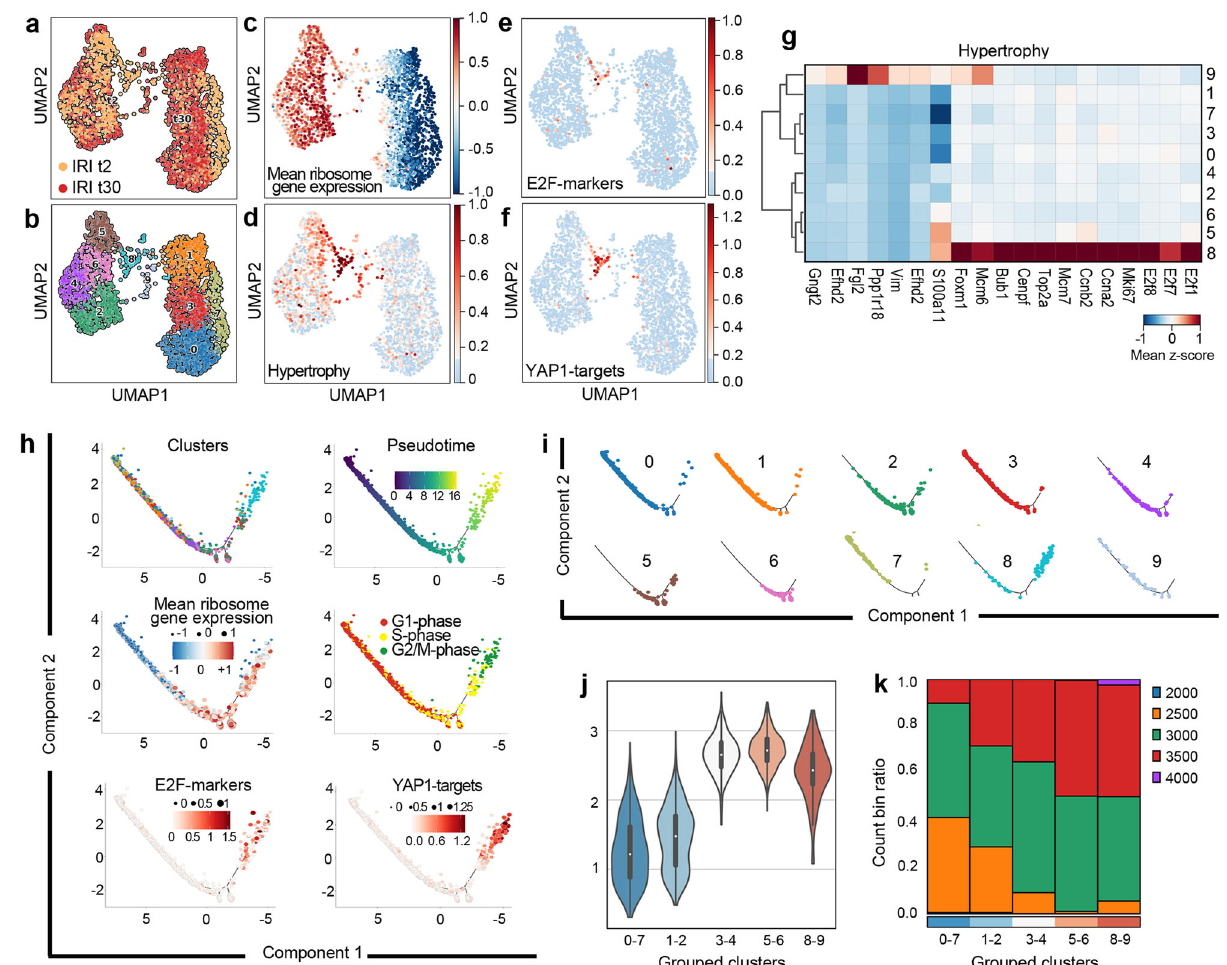
Fig. 3 | Polyploidization of proximal tubular cells (PTC) after AKI in mice is controlled by YAP1. a UMAP of experimental time distribution and b cluster distribution of mouse PTC at day 2 (t2) and 30 (t30) after IRI. c UMAP showing ribosome gene expression difference and d hypertrophy genes (Top2a, Mcm7, Ccna2, Ccnb2, Tmsb10, S100a11). e UMAP showing E2F-markers (E2f1, E2f7, E2f8) and f YAP1-targets (Ankdr1, Birc5, Ctgf, Cdk1, Ccnb1, Akt1) in PTC. g Matrix plot of PTC at 2 and 30days afterIRI, showing hypertrophy genes. h Monocle2 trajectory of PTC clusters and trajectory of PTC coloured by pseudotime, mean ribosome gene expression difference, cell cycle phases, E2F-markers (E2f1, E2f7, E2f8) and